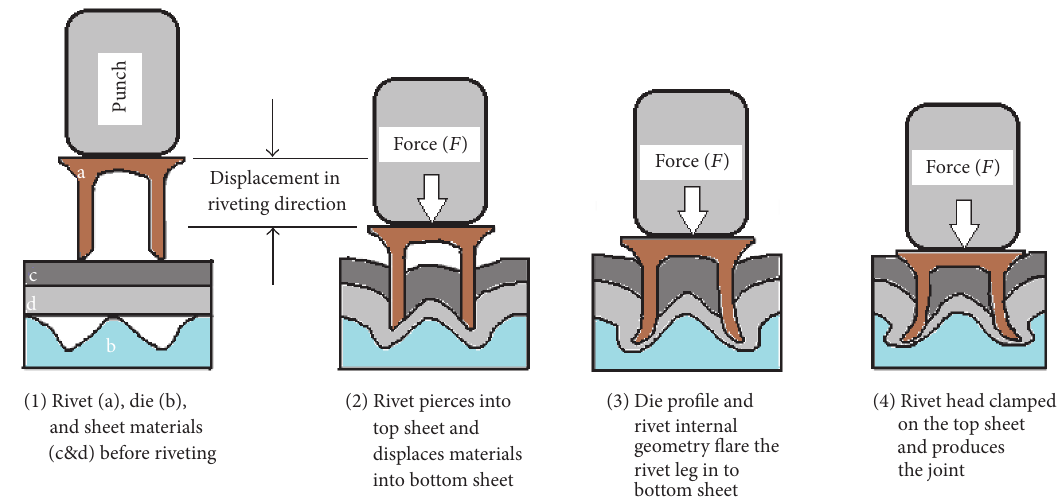
Figure 1: Graphical representation of the SPR joining, modified from [1,